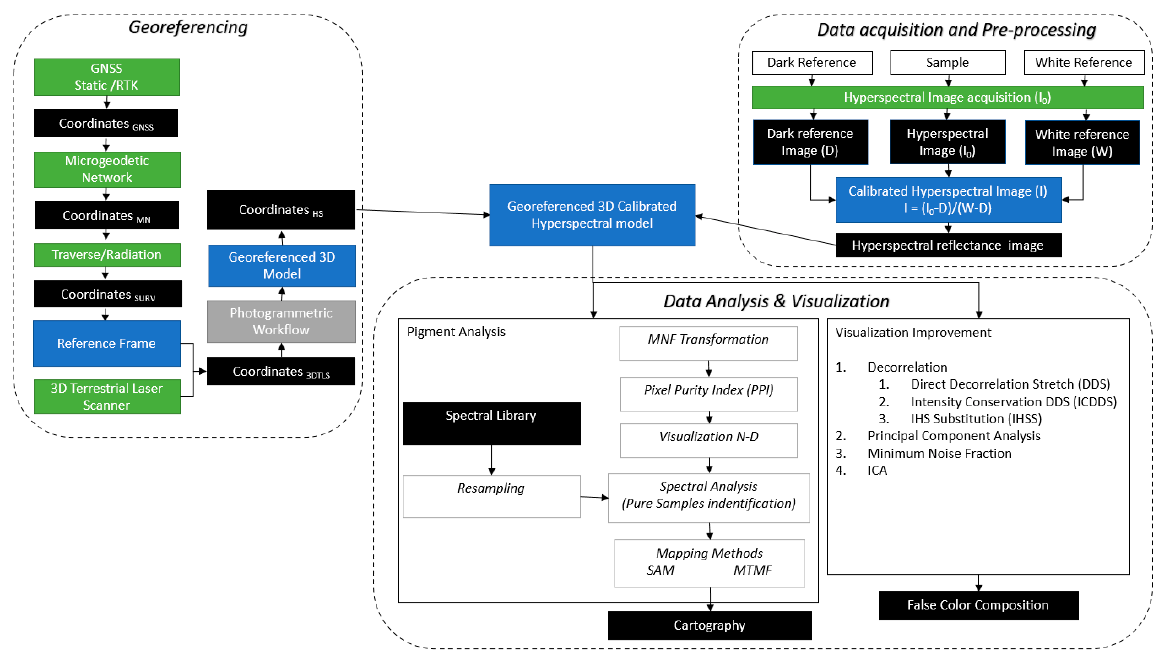
Figure 4. Detailed workflow of the proposed method. Adapted from [3,4].